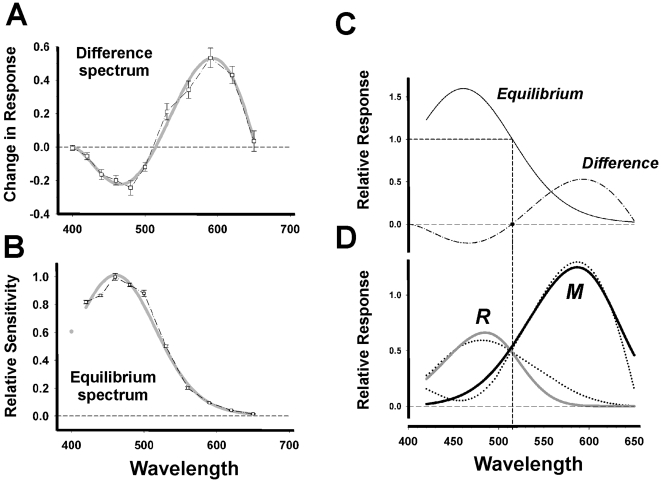
Difference and Equilibrium spectra and modelling of the putative R and M absorption spectra.(A) The difference spectrum was obtained by measuring the change in pupil constriction between the two identical reference and test stimulations (480 nm, 1e12 photons/cm2/sec, 5 min duration) subsequent to a 5 min pre-exposure period for 11 different wavelengths (n = 4 subjects; iso-irradiance of 14.1±0.2 log photons/cm2/s). Consistent with typical difference spectra of invertebrates, the response function (5-degree polynomial, R2 = 0.91) shows two domains: a decrease in the response between 400–515 nm (min = 466 nm) and an increase in constriction for longer wavelengths (515–650 nm, max = 592 nm). The response function also shows an isosbestic point that corresponds to the wavelength at which the pre-exposure stimulation has a neutral effect (514.3±1.2 nm). (B) Equilibrium spectrum (4-degree polynomial, R2 = 0.99) obtained using the pupil constriction observed in response to the different pre-exposure wavelengths (n = 4, for details see Methods). The data point at 400 nm (gray circle) is from a single subject and thus was not included in the spectral response curve. The peak response is at 460 nm. For A–B the gray line shows the fitted curve. (C) Illustrates normalization of the equilibrium spectrum (B) to 1.0 at the isosbestic point obtained from the difference spectrum (A). We applied the mathematical model developed by Stavenga [19], [20] that allows calculation of the R and M absorption spectra for IRP. (D) Illustrates the two putative spectra that peak at 481 nm (R state) and 587 nm (M state) corresponding to melanopsin and “metamelanopsin” isoforms. The two derived spectra (dashed lines) show a good fit with the vitamin A nomograms (solid gray and black lines) with maxima at 484 nm (R2 = 0.82) and 587 (R2 = 0.97) nm respectively.